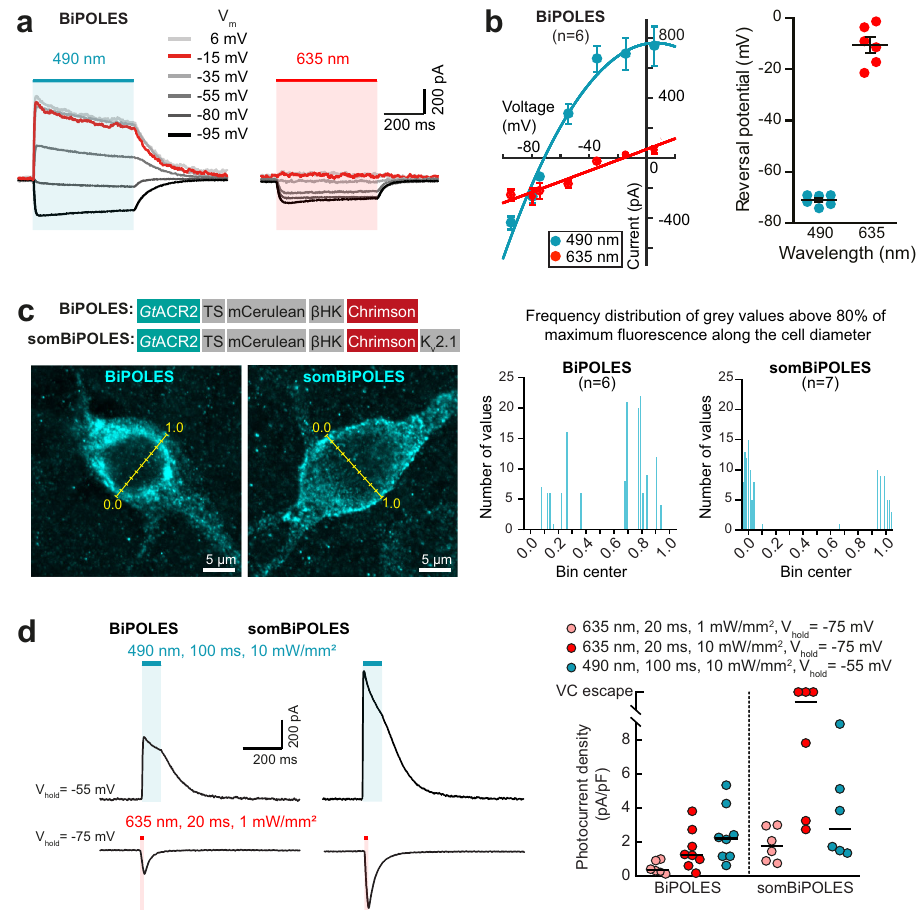
Fig. 2 Expression and functional characterization of BiPOLES and somBiPOLES in hippocampal neurons. a Representative photocurrent traces of BiPOLES in CA1 pyramidal neurons at indicated membrane voltages ( V m : from − 95 to + 6mV) upon illumination with 490 or 635nm (500ms, 10mWmm − 2 ). b Left: quanti fi cation of photocurrent-voltage relationship (symbols: mean±SEM, n = 6 cells, lines: polynomial regression fi tting, R 2 = 0.98 and 0.94, for 490 and 635 nm, respectively). Right: reversal potential under 490 or 635nm illumination (black lines: mean ±SEM, n = 6 cells). c Left: Molecular scheme of BiPOLES and somBiPOLES as used in neurons. Representative maximum-intensity projection images of immunostainings showing expression of BiPOLES or soma- targeted BiPOLES (somBiPOLES) in CA3 pyramidal neurons of organotypic hippocampal slices. Yellow lines indicate the bins used to measure fl uorescence intensity along the cell equator. Right: Frequency distribution of gray values above 80% of the maximum fl uorescence intensity measured along the cell diameter in BiPOLES-expressing ( n = 6 cells) and somBiPOLES-expressing CA3 cells ( n = 7 cells). Note improved traf fi cking of somBiPOLES to the cell membrane, shown by the preferential distribution of brighter pixels around bins 0.0 and 1.0. d Left: Representative photocurrent traces measured in BiPOLES- expressing or somBiPOLES-expressing CA1 pyramidal neurons. Inward cationic photocurrents evoked by a 635nm light pulse (20 ms, 1 mW mm − 2 ) were recorded at a membrane voltage of − 75mV, and outward anionic photocurrents evoked by a 490 nm light pulse (100ms, 10mW mm − 2 ) were recorded at a membrane voltage of − 55mV. Right: Quanti fi cation of photocurrent densities evoked under the indicated conditions. Note that photocurrent densities were strongly enhanced for somBiPOLES compared to BiPOLES (black horizontal lines: medians, n BiPOLES = 8 cells, n somBiPOLES = 6